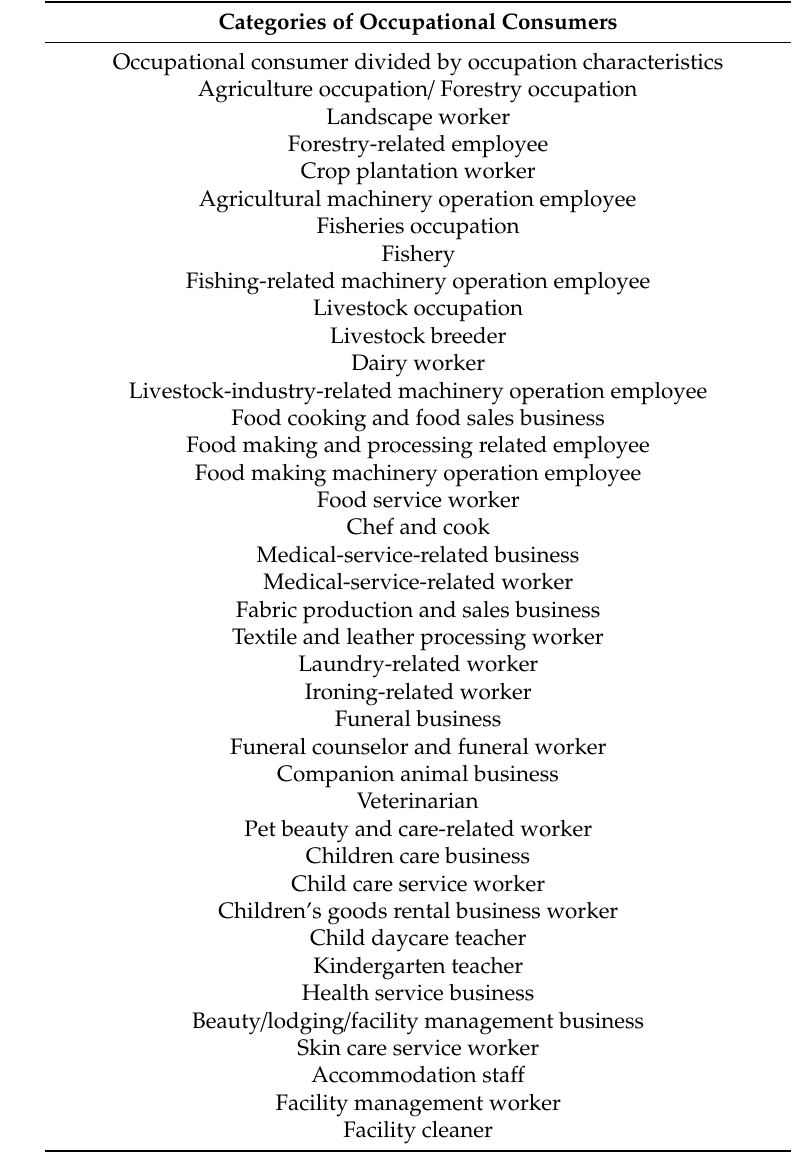
Table 2. Categories of occupational consumers using biocidal products due to